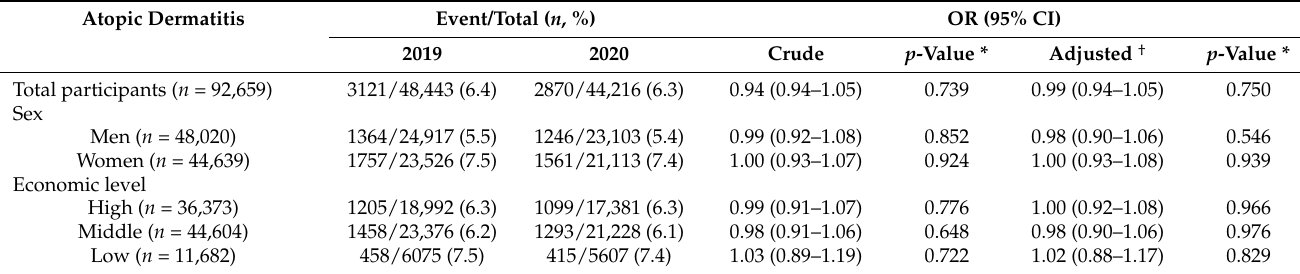
Table 4. Odd ratios in atopic dermatitis of 2020 compared to those in 2019 in total participants and subgroup. Atopic